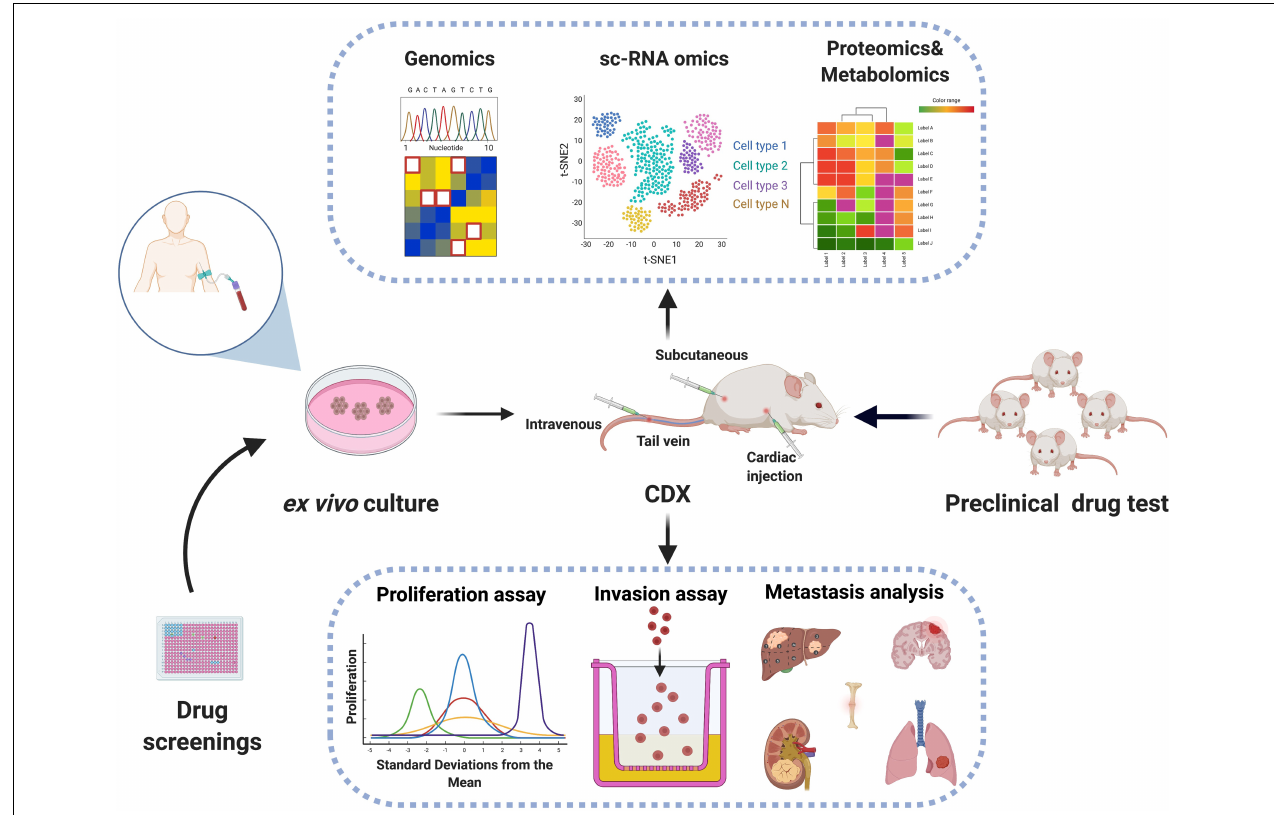
FIGURE 1 | Biological characterization of CTCs using CTC-based model systems. Viable CTCs may be isolated from patient blood samples followed by ex vivo expansion in plates and in vivo inoculation in immunocompromised mice. The establishment of CTC cell lines and CTC-derived mouse explants (CDX) may